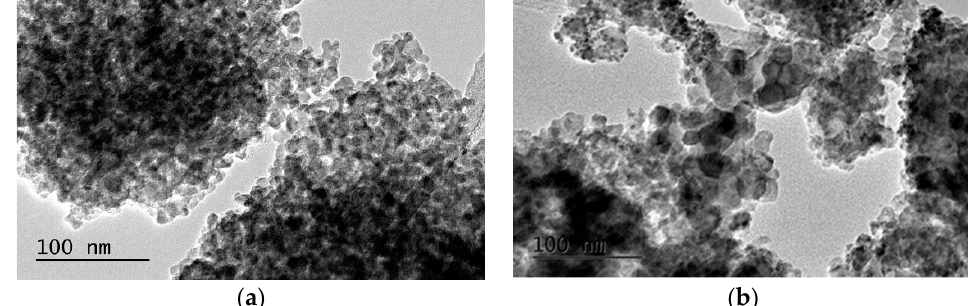
Figure 5. Bright field TEM micrographs from selected areas of samples 90TiO 2 /10TeO 2 heat treated at 600 °C ( a ) and 90TiO 2 /10TeO 2 /Pd ( b ).